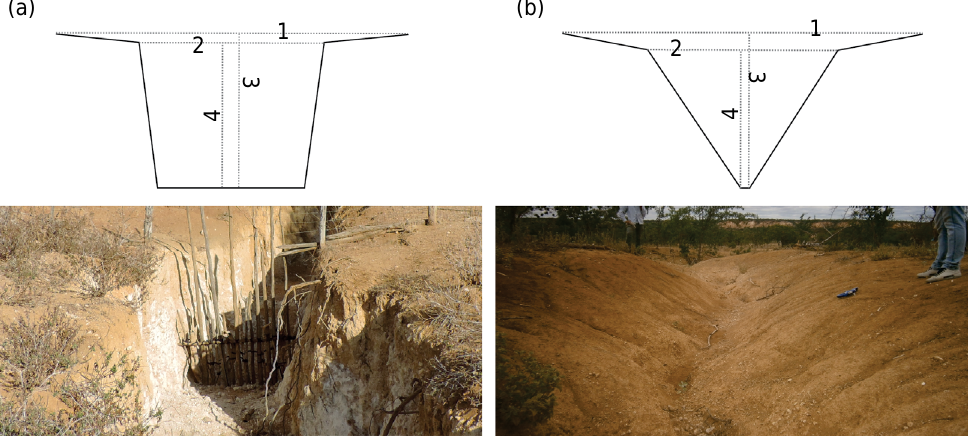
Figure 3. Illustrations and photographs of the typologies of shapes of the linear erosion features (LEFs). U-shaped linear incision (a); V-shaped linear incision (b). 1: width of extreme points of the LEFs (WE); 2: width inside the LEF (WI); 3: depth from WE (DE); 4: depth from WI